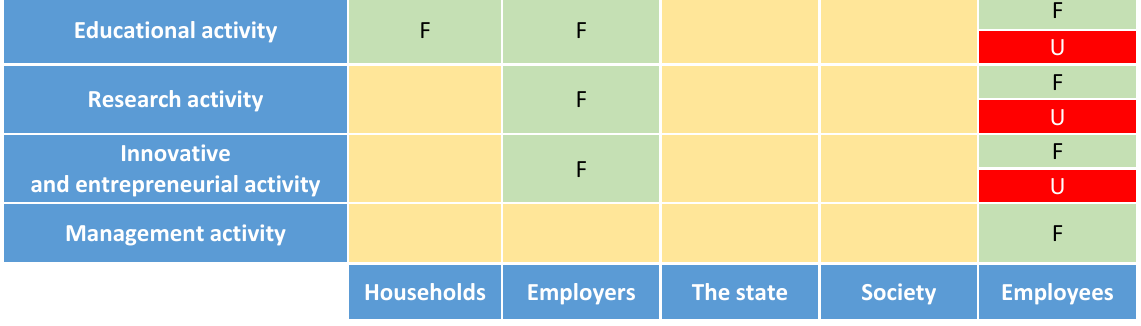
Figure 3. The matrix of initiative